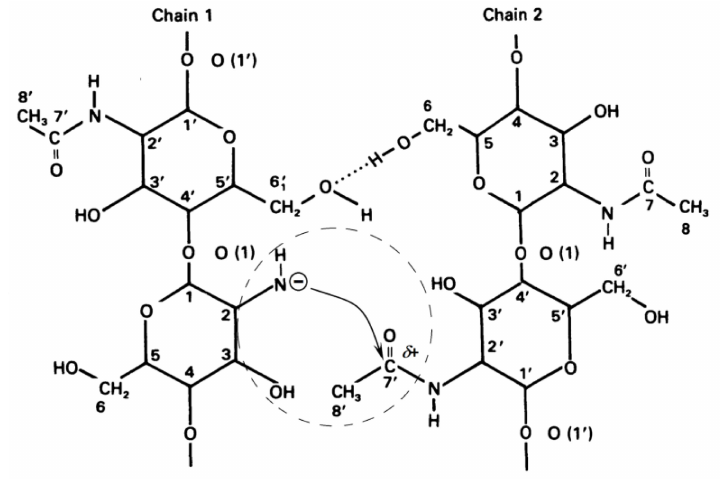
Figure 17. Scheme of the influence of the negative charge of the quasi-stable amide anion of chitosan on the electron density of the carbon of the acetamide bond of the neighboring chitin molecule.